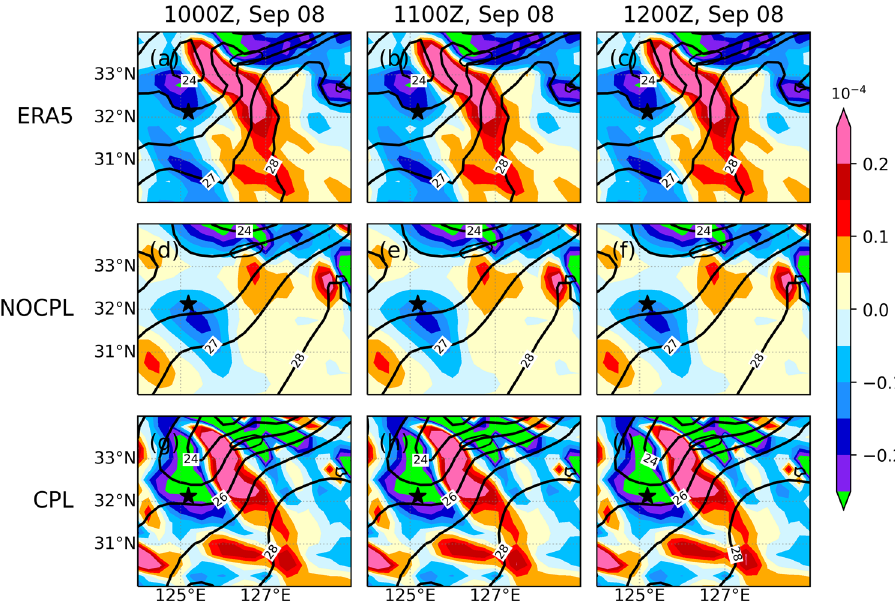
Figure 6. Horizontal distribution of sea surface temperature (°C; contour) and its gradient (10 –4 K/m; shaded) for (top) ERA5, (middle) NOCPL, and (bottom) CPL every 1 h. The uncoupled and coupled results are regridded to 0.25° resolution of the ERA5 grid. The black star indicates the location of the Ieodo ORS.